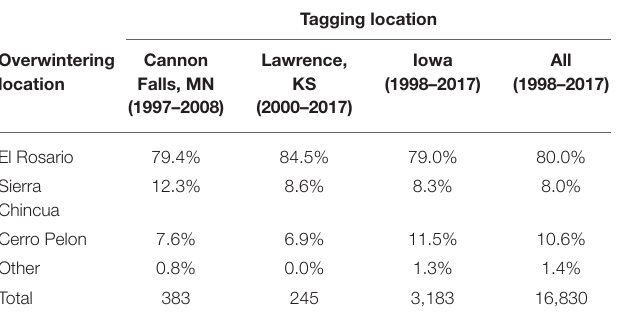
TABLE 1 | Examples of distribution of recovered tags among locations in the Monarch Butterfly Biosphere Reserve (MBBR) representing season-long records for Cannon Falls, Minnesota, 1-day events in Lawrence, Kansas, the entire record for Iowa and for all recoveries between 1998 and 2017.